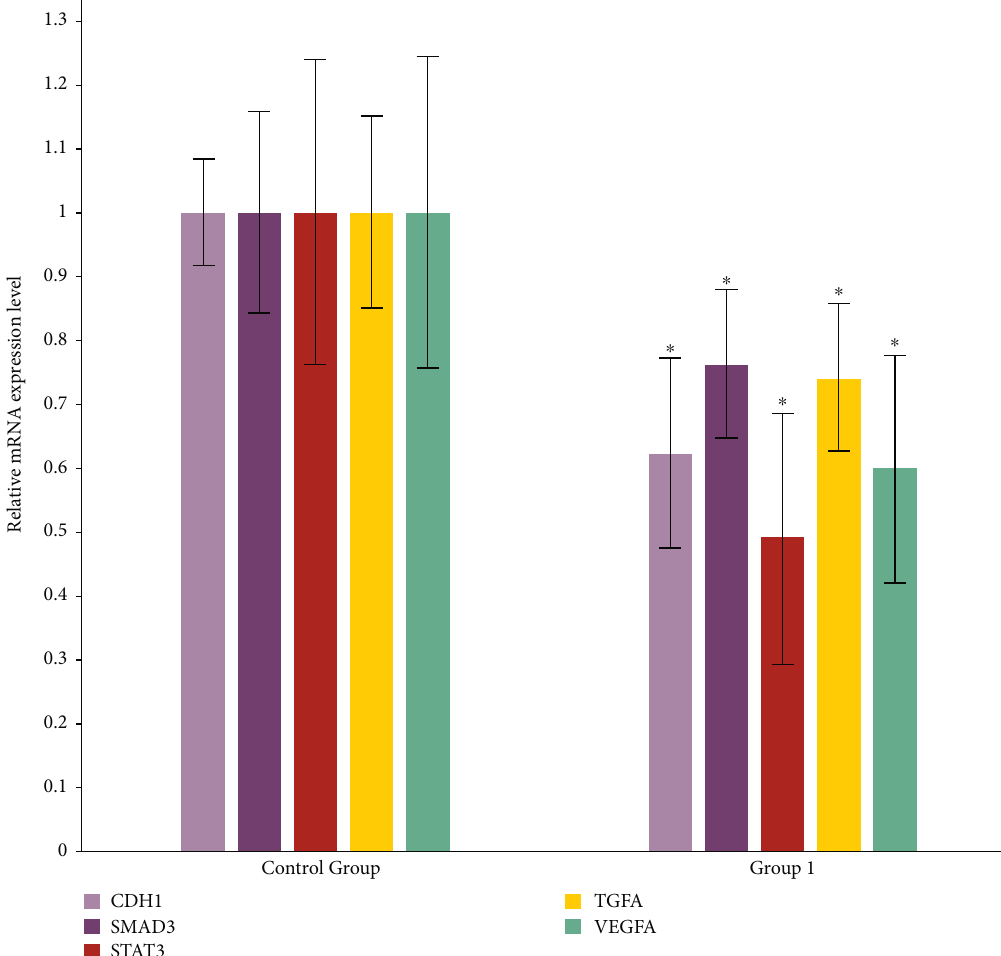
Figure 5: Five genes of interest showed signi fi cant downregulation in anastomotic tissues in the MSC-treated group ( n = 3 ) as compared with that in the control group ( n = 3 ). ∗ P < 0 : 05 vs. control